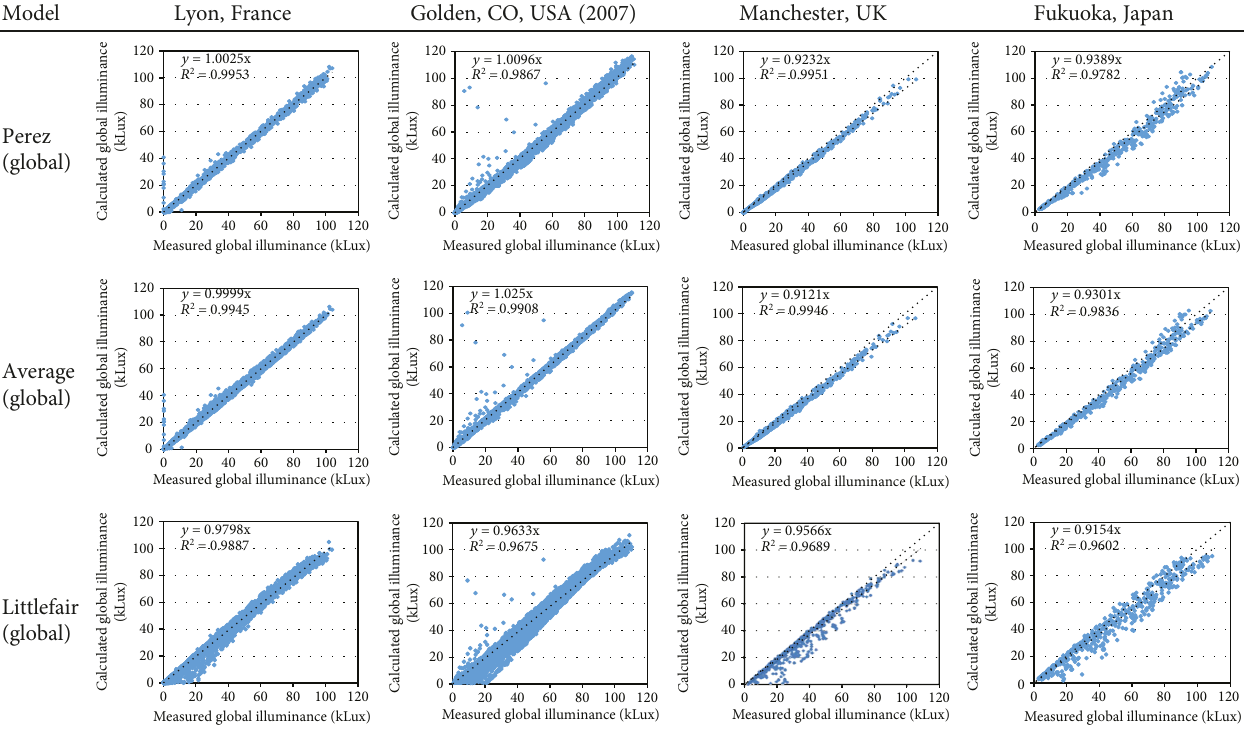
Table 4: Comparative analysis of global luminous e ffi cacy models ’ performance for four worldwide cities.